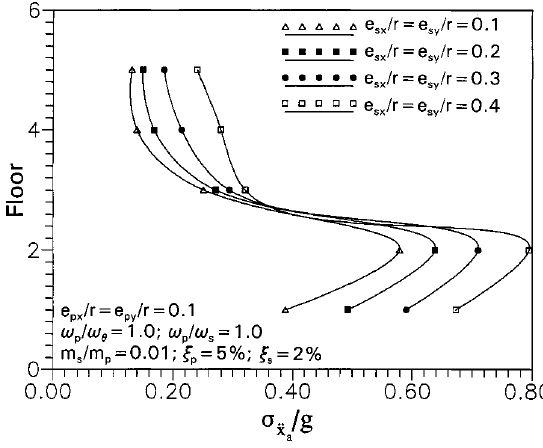
=g with storey height for various values of Fig. 9. Variation of (cid:27) (cid:127) x a e p x =r and e p y =r ; for m s =m p = 0.01; ! p =! s = 1.5; ! p =! (cid:18) = 0.5; e s x =r = e s y =r = 0.3; (cid:24) p = 5% and (cid:24) s = 2%.